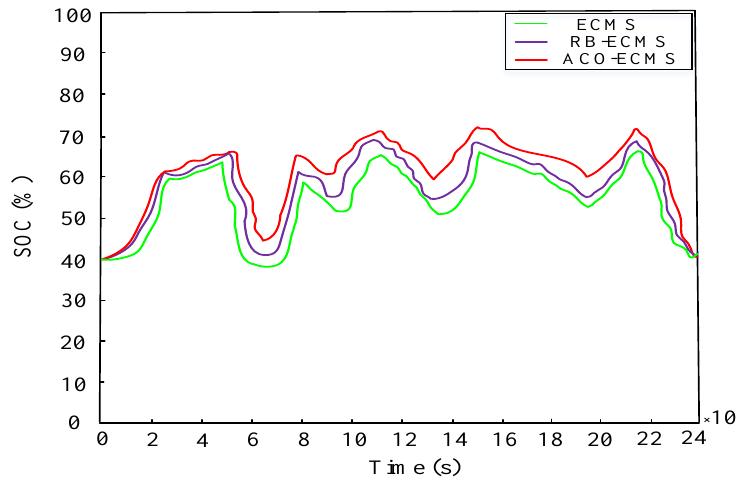
Figure 10. State-of-charge (SOC) simulation results of a complete operation condition.